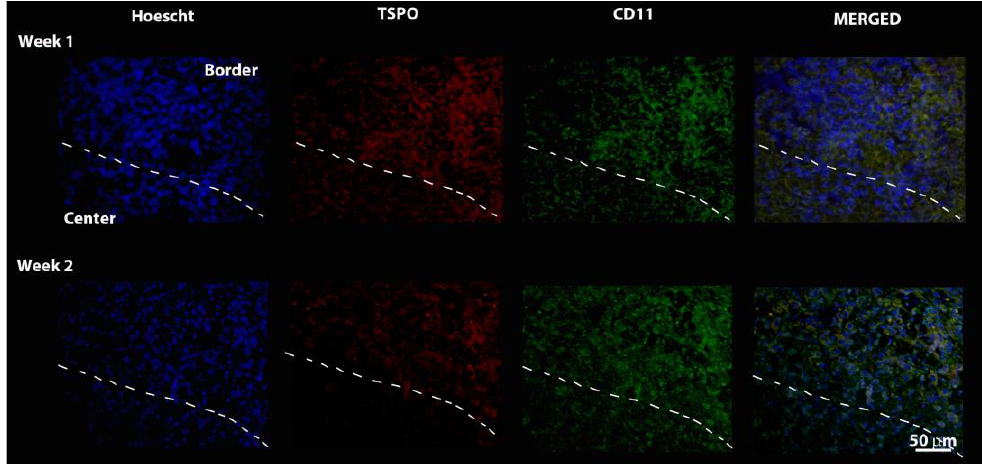
Figure 7. Images of immunofluorescence reactions in tumor tissue with Hoechst dye (Nucleus), TSPO, CD11 (macrophages), and fusion of all three. The dashed line divides the tissue sections into an upper (edge) and lower (center) region.